Question: According to the figure, is the described quantity increasing or decreasing?
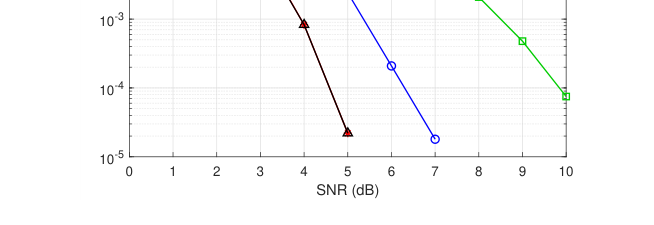
Answer: decreasing